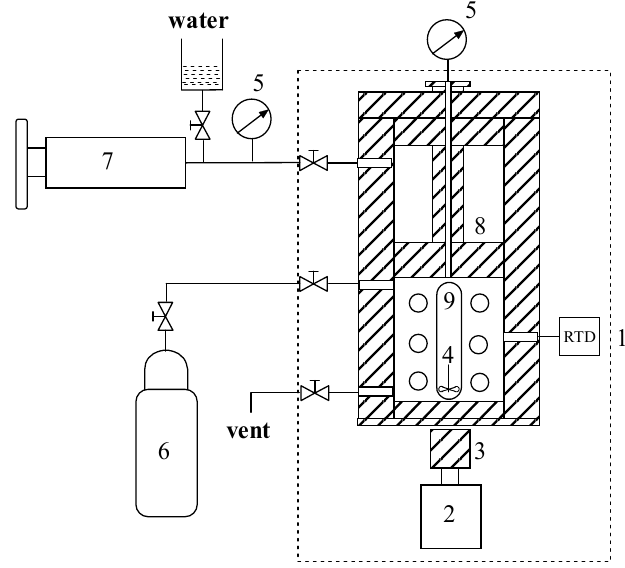
Figure 2. Schematic diagram of experimental apparatus used for solubility measurement and hydrate formation and dissociation study: 1. air bath; 2. motor; 3. magnet; 4. magnetic stirrer; 5. pressure gauge; 6. gas cylinder; 7. hand pump; 8. piston; 9. observation window; RTD: resistance thermocouple